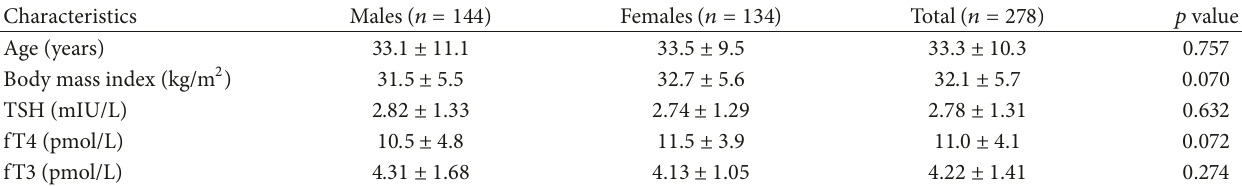
Table 1: Age, body mass index, and thyroid hormones serum levels (mean ± SD) according to participants’ gender.